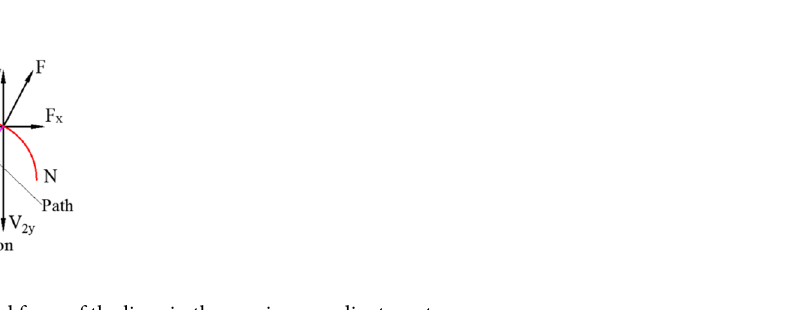
Figure 15. Velocity and force of the liner in the moving coordinate